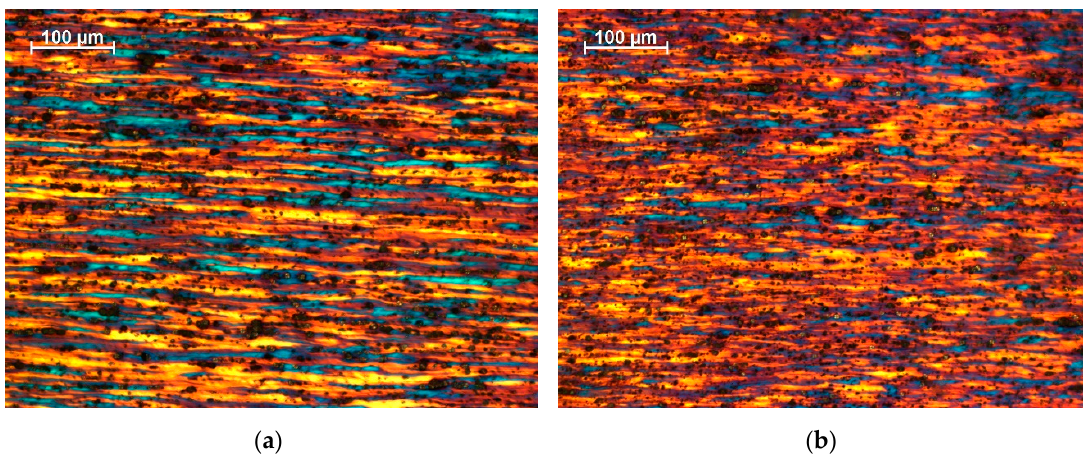
Figure 1. Optical microscope images of the ( a ) UD (A5) and ( b ) CR (A4K) samples.